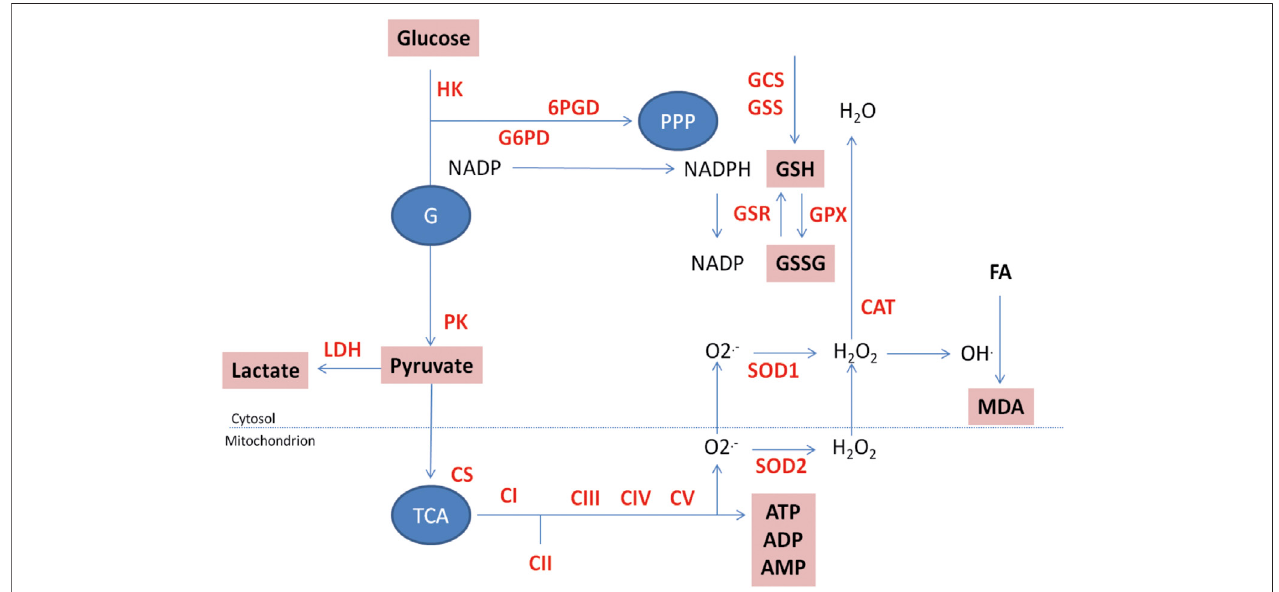
FIGURE3| Functionalenergymetabolism:visualizationofmetaboliccascades.Todate,22analytesandenzymes,presentedontheschemaabove,aremeasured in parallel on the platform. GSH and GSSG, ATP, ADP, and AMP are measured by capillary electrophoresis. All CV% of the different techniques are below 5%. HK: hexokinase; G6PD: glucose 6-P dehydrogenase; 6PGD: 6P-gluconolactone dehydrogenase; PK: pyruvate kinase; LDH: lactate dehydrogenase; CS: citrate synthase; CI to CV: ETC complexes I to V; SOD1: CuZn superoxide dismutase; SOD2: MnSOD; CAT: catalase; GSR: glutathione disul fi de reductase; GPX: glutathione peroxidase; GCS: c -glutamyl cysteinyl synthase; GSS: glutathione synthetase; PK: Pyruvate kinase; LDH: lactate dehydrogenase. GSH: reduced glutathione; GSSG: oxidizedglutathione;MDA:malonedialdehyde.G:glycolysis;PPP:pentosephosphatepathway,TCA:tricarboxylicacidcycle;FA:Fattyacids.Measuredenzymesinred; measured molecules in bold in